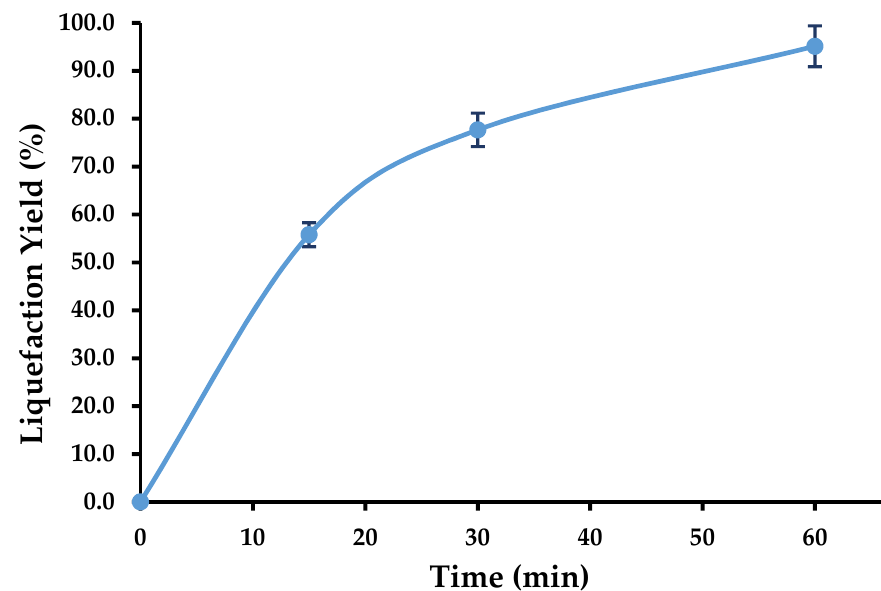
Figure 4. Study of liquefaction yield along liquefaction time for Broom branches for the fraction > 80 mesh (powder) at 180 °C with acid catalysis.